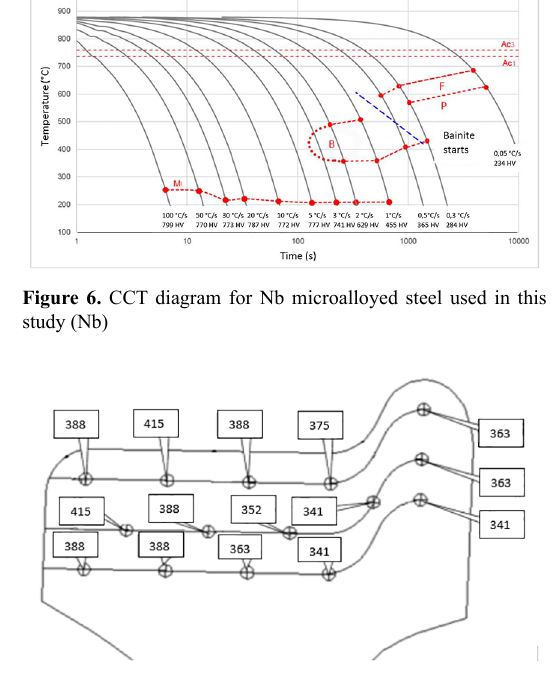
Figure 7. Brinell hardness map of Nb steel.